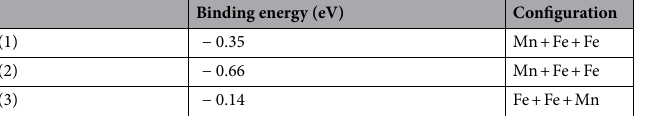
Table 2. Binding energies of the 3A tri-vacancy cluster with different atomic vacancy formation sequences.